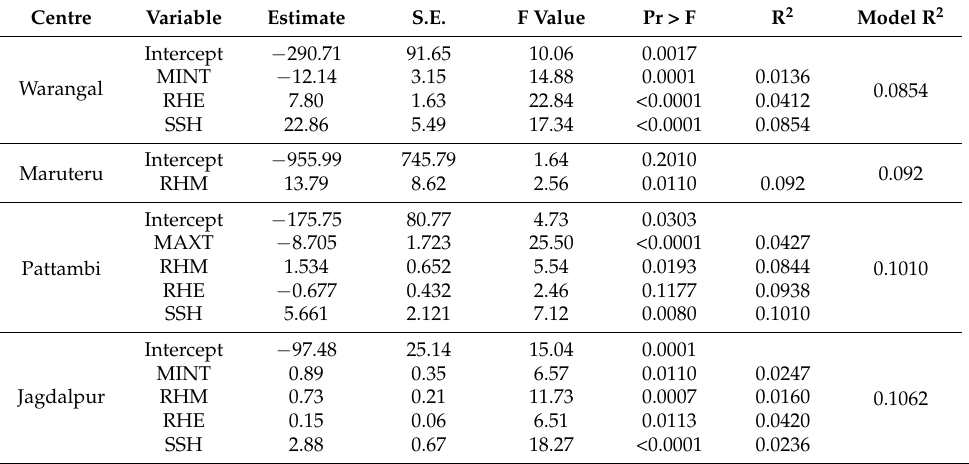
Table 3. Stepwise regression analysis of gall midge light trapped individual collections and climato- logical variables at study